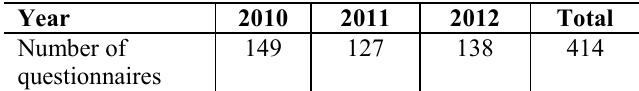
Table 2: Total number of questionnaires